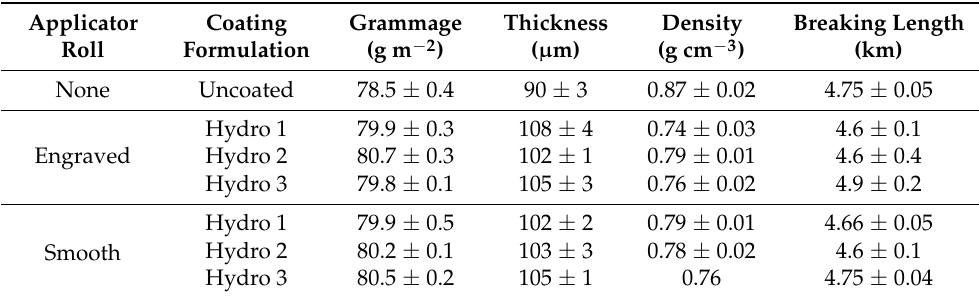
Table 3. Key properties of the sheets coated with hydrophobic formulations. The amplitude of the intervals equals twice the standard deviation.